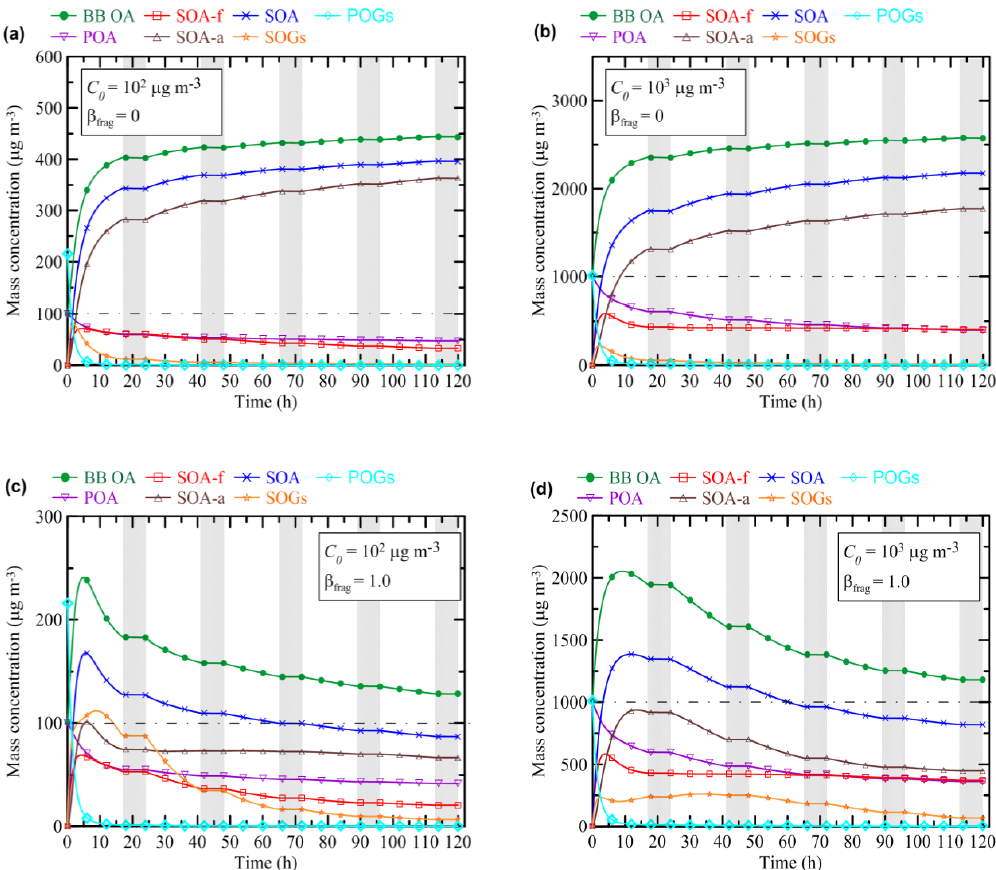
Figure 10. Evolution of the mass concentration of BB OA and its components, including POA, “fresh” SOA (SOA-f), and “aged” SOA (SOA-a), according to the simulations performed with the S15 scheme. Also shown are the total mass concentration of SOA and the mass concentrations of POGs and SOGs. The simulations were done with two different values of β frag , (a, b) β frag = 0 and (c, d) β frag = 1, and two different values of C 0 , (a, c) C 0 = 10 2 µgm 3 and (b, d) C 0 = 10 3 µgm 3 . The initial plume size was set at 100km in all the simulations. A horizontal dashed–dotted line in each panel indicates the initial concentration of BB OA aerosol. Shaded bands depict nighttime periods when no oxidation reactions were allowed to